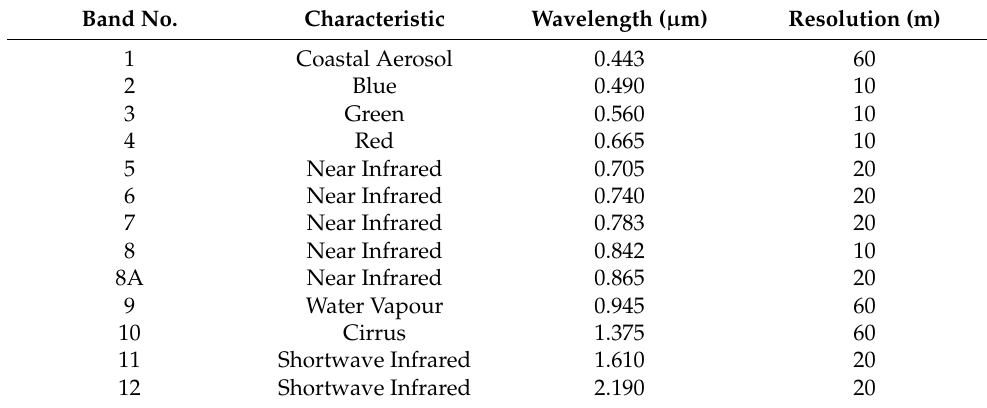
Shortwave Infrared Shortwave